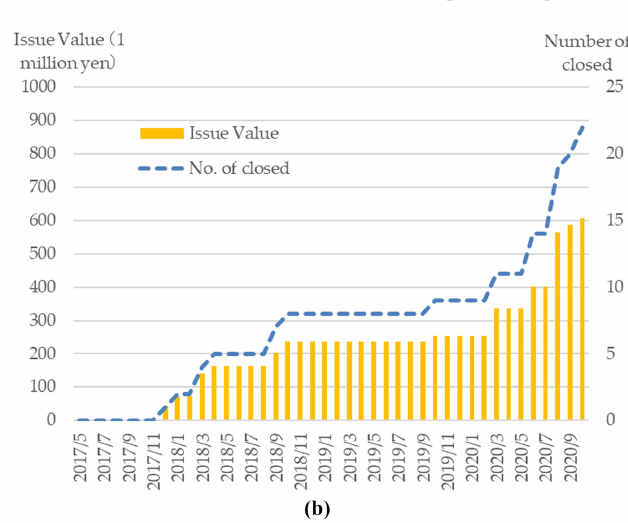
Figure 1. Status of